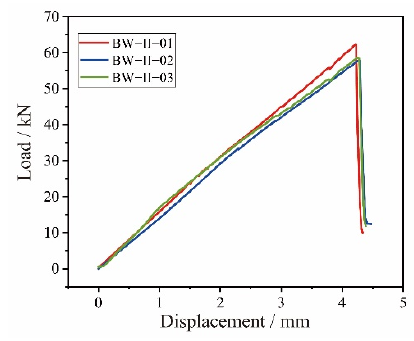
Figure 9. Load-displacement curves from the shear experiments on the PWF composite beams of BW-II. Table 5. Experimental results of the failure load and critical buckling load—the PWF composite beams of BW-II.